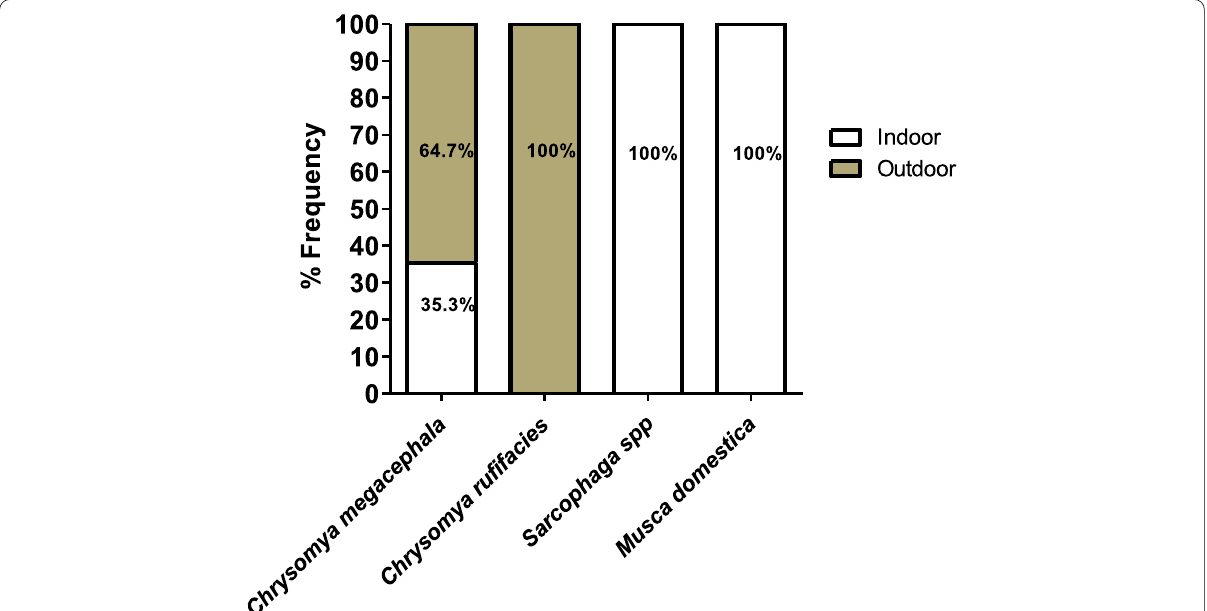
Fig. 7 Frequency of occurrence of necrophagous fly species of forensic importance in indoor and outdoor